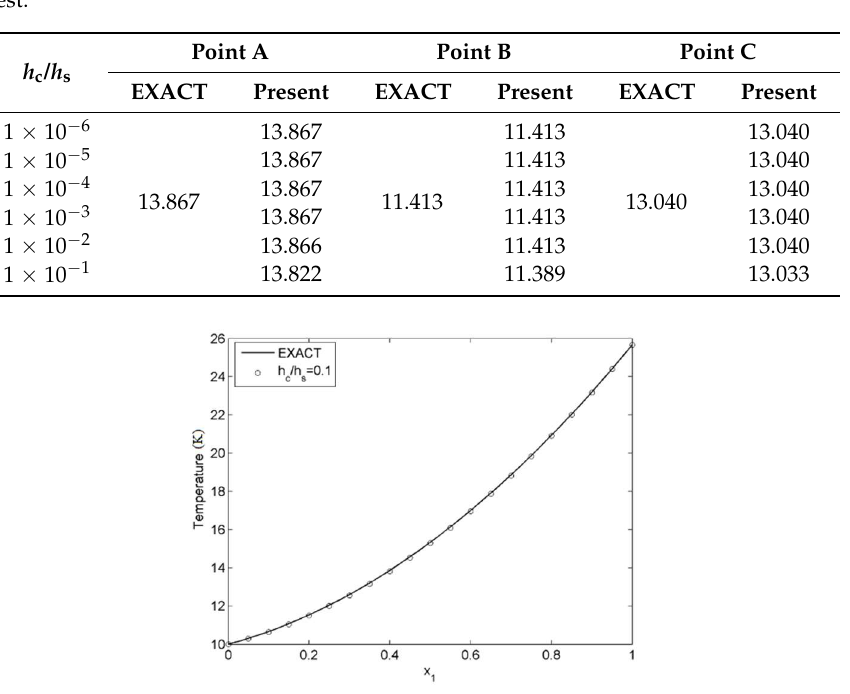
Table 2. Temperature results at the three specific points for different thickness ratios for η = 10 in the second test.